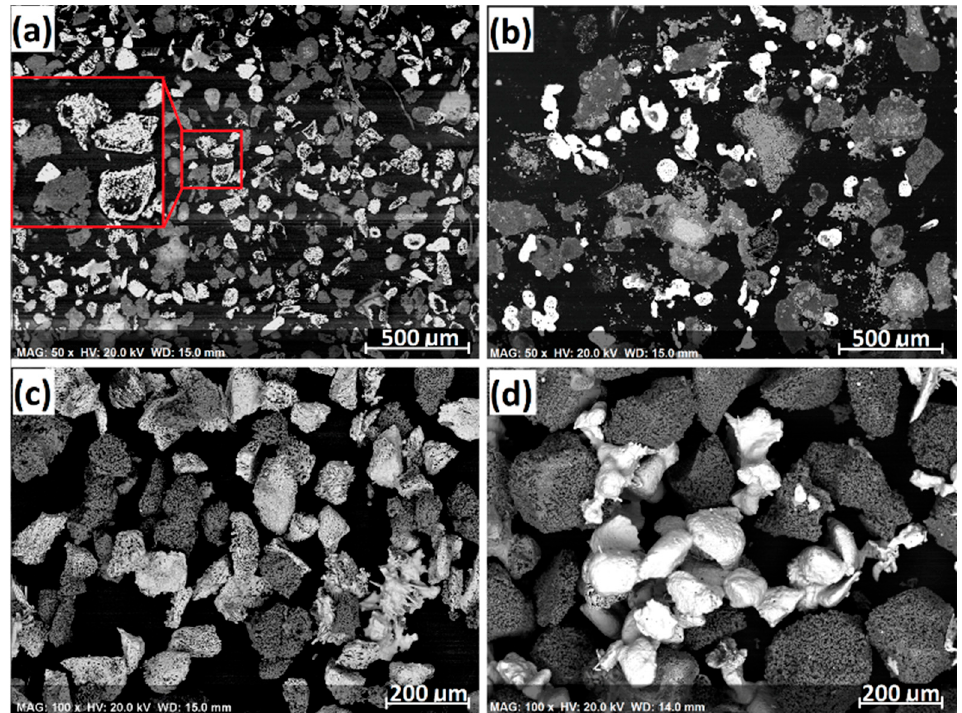
Figure 3. Backscattered electron (BSE) micrographs of the products formed using 75–105 µm chromite ( a , c ) and 180–300 µm chromite ( b , d ). Photomicrographs a and b represent polished section surfaces while c and d show surface morphologies of the reduced products.